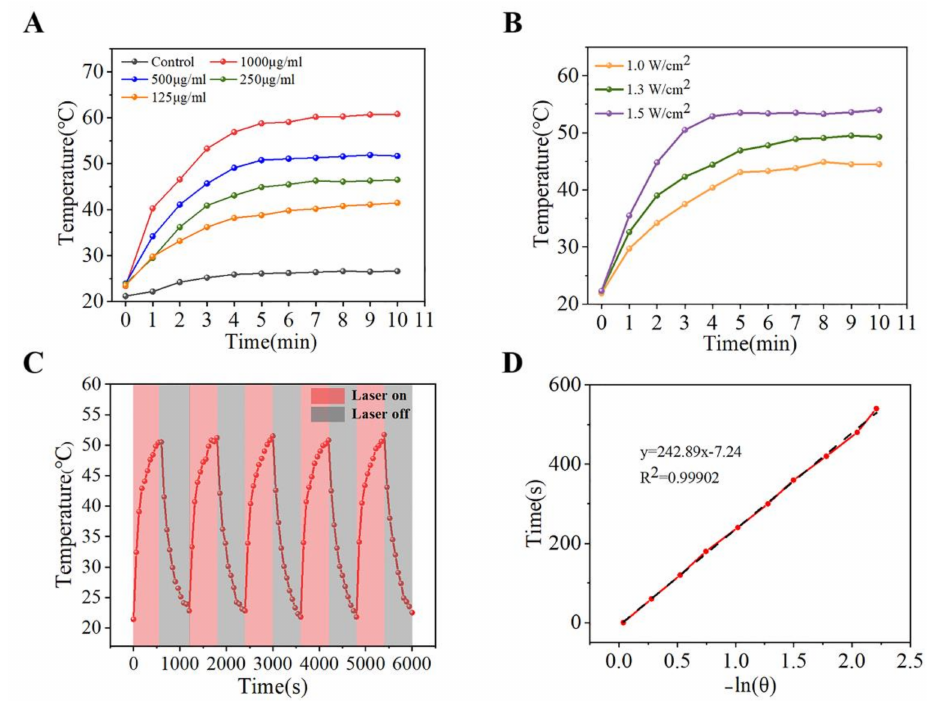
Figure 4. Photothermal properties of PDA-PLLA/CM microparticles. ( A ) Temperature variation at different concentrations under 808 nm irradiation (1.3 W/cm 2 ) for 10 min, ( B ) at different powers of irradiation (500 µ g/mL) for 10 min, and ( C ) over 5 irradiation cycles (808 nm, 500 µ g/mL, 1.3 W/cm 2 ). ( D ) Fitting curves of the time logarithm of the temperature during the cooling